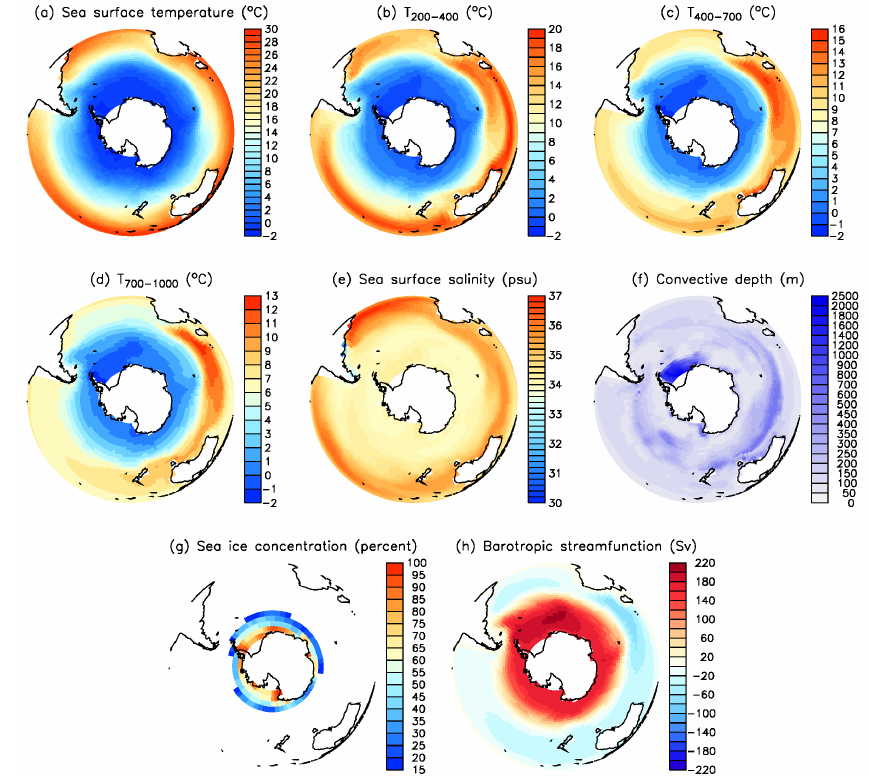
Figure 4. Annual-mean climatology for the pre-industrial control simulation: (a) sea surface temperature ( ◦ C), (b) mean temperature at a depth of 200–400m ( ◦ C), (c) mean temperature at a depth of 400–700m ( ◦ C), (d) mean temperature at a depth of 700–1000m ( ◦ C), (e) sea surface salinity (psu), (f) convective depth (m), (g) sea ice concentration (%) and (h) barotropic streamfunction